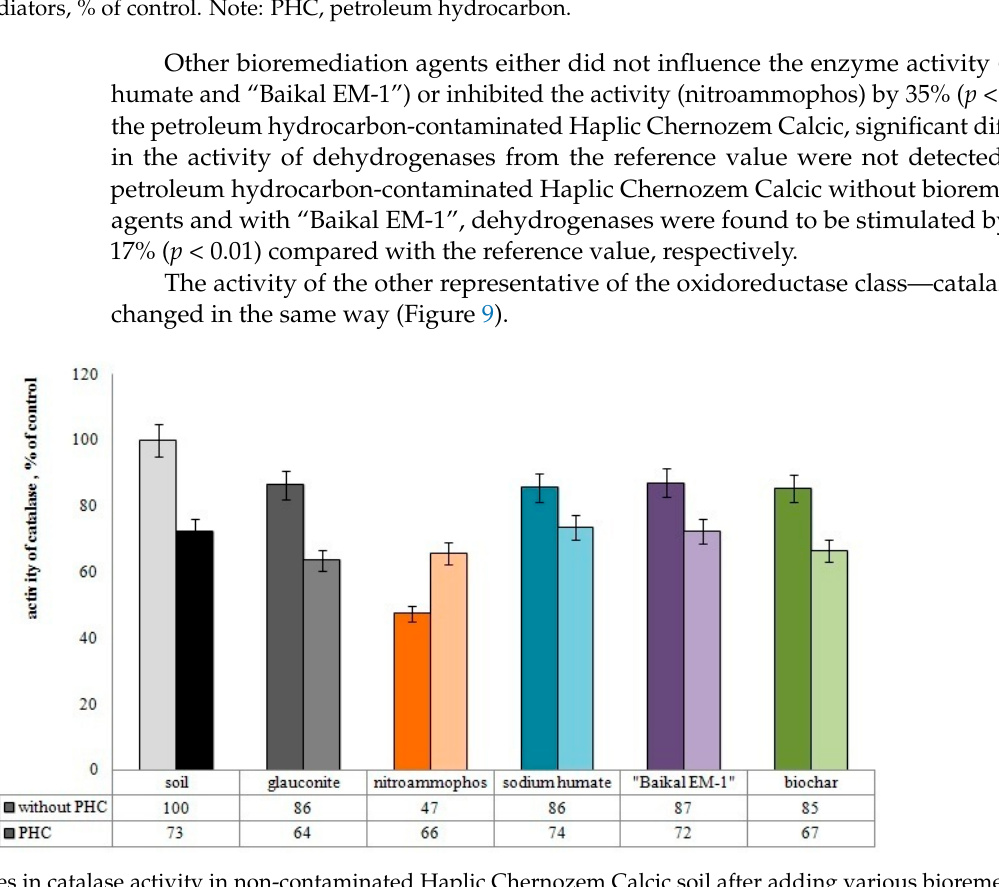
Figure 9. Changes in catalase activity in non-contaminated Haplic Chernozem Calcic soil after adding various bioremediators, % of control. Note: PHC, petroleum hydrocarbon.